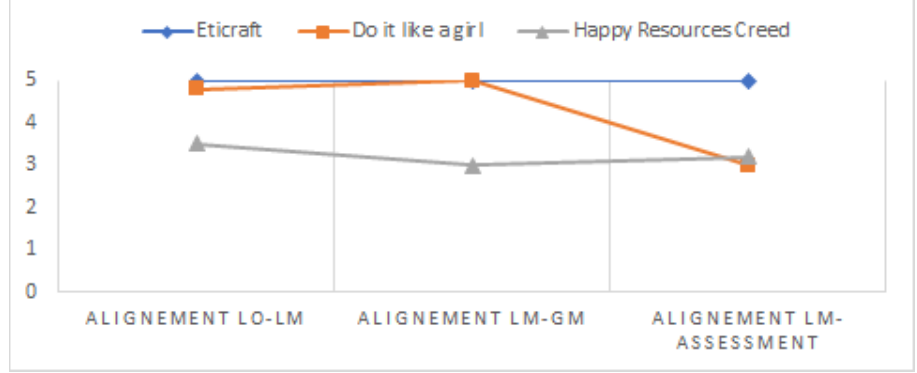
Figure 3. Average results on the alignment (LO-LM, LM-GM, LM-Assessment).